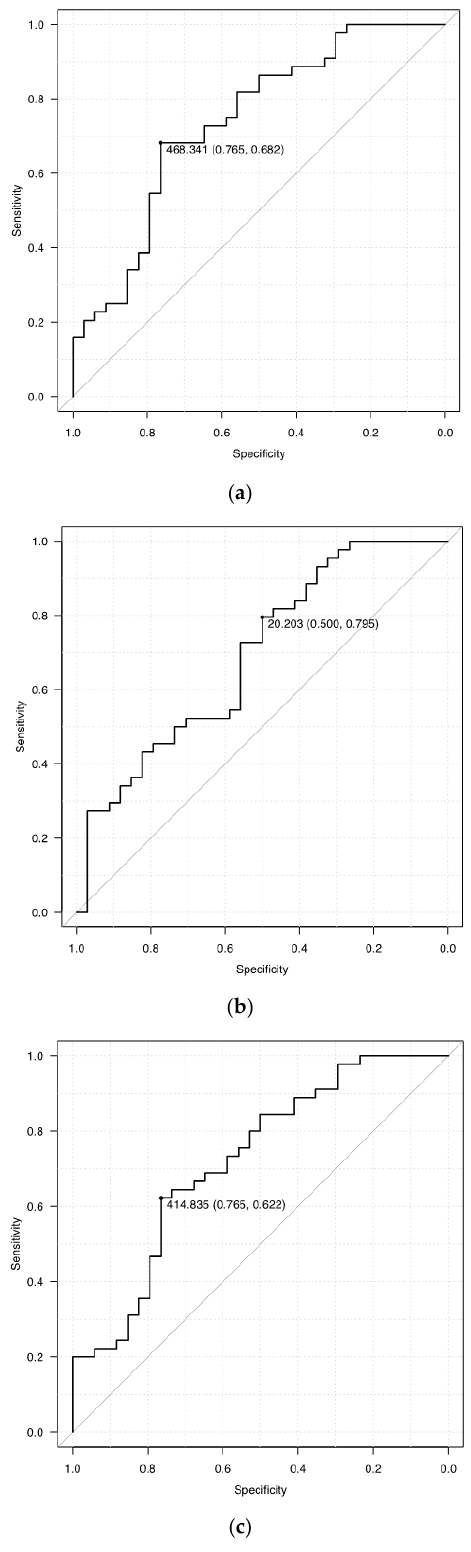
Figure 4. The receiver operating characteristic curves of the opacity volume as a predictor of oxygen demand. The sensitivity, specificity, and AUC of the volume of opacity were 76.5%, 68.2%, and 0.737 in predicting increased oxygen demand ( a ); 50.0%, 79.5%, and 0.691 for high opacity ( b ); and 76.5%, 62.2%, and 0.722 for low opacity ( c ),